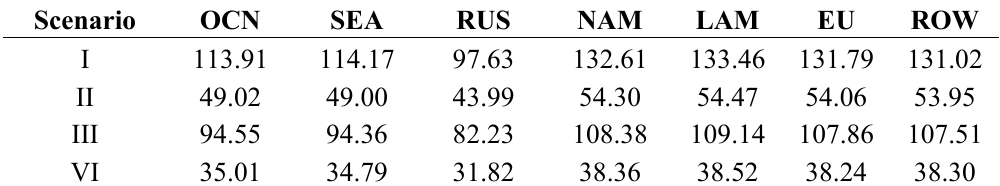
Table 5. Percentage changes in exports to China.